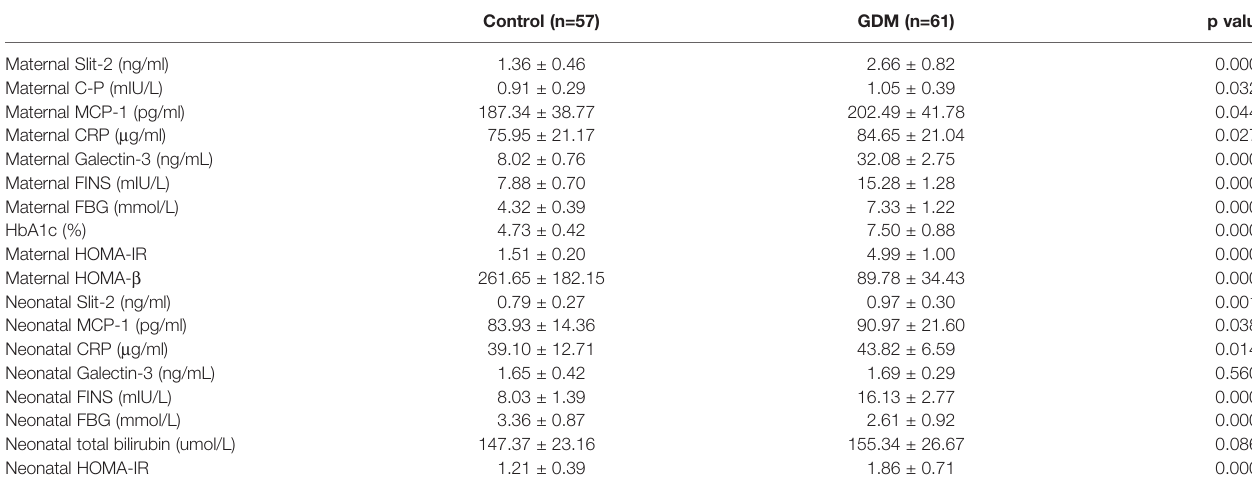
TABLE 2 | Research results of study population.